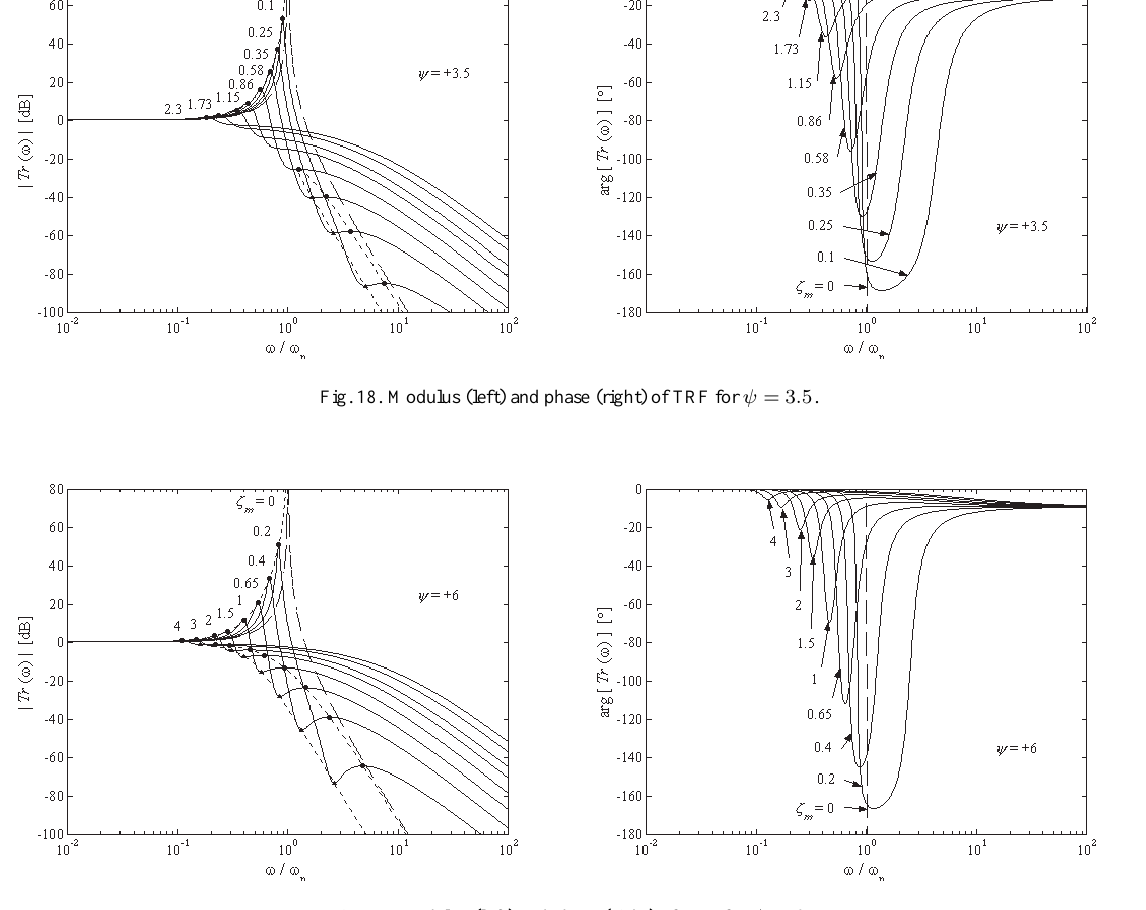
Fig. 19. Modulus (left) and phase (right) of TRF for ψ = 6